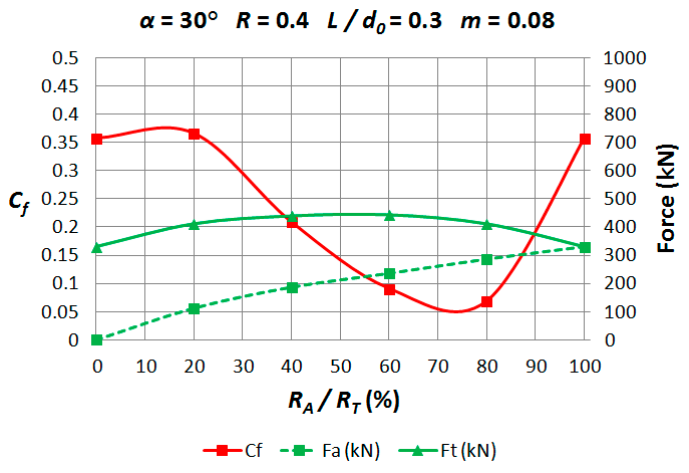
Figure 11. Damage factors ( C f ) and forces versus R A / R T .